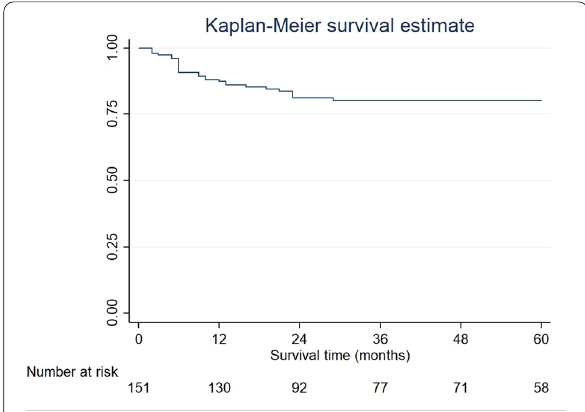
Fig. 3 Kaplan–Meier curves of the 5-year cumulative implant survival